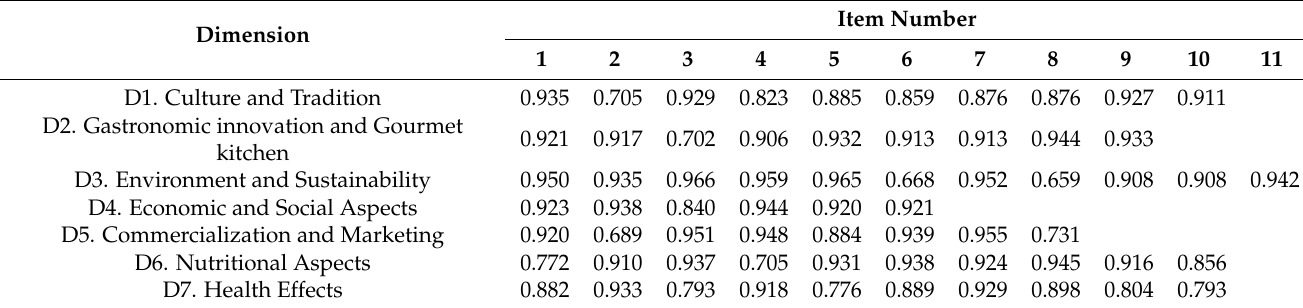
Table 3. Values of measure of sample adequacy